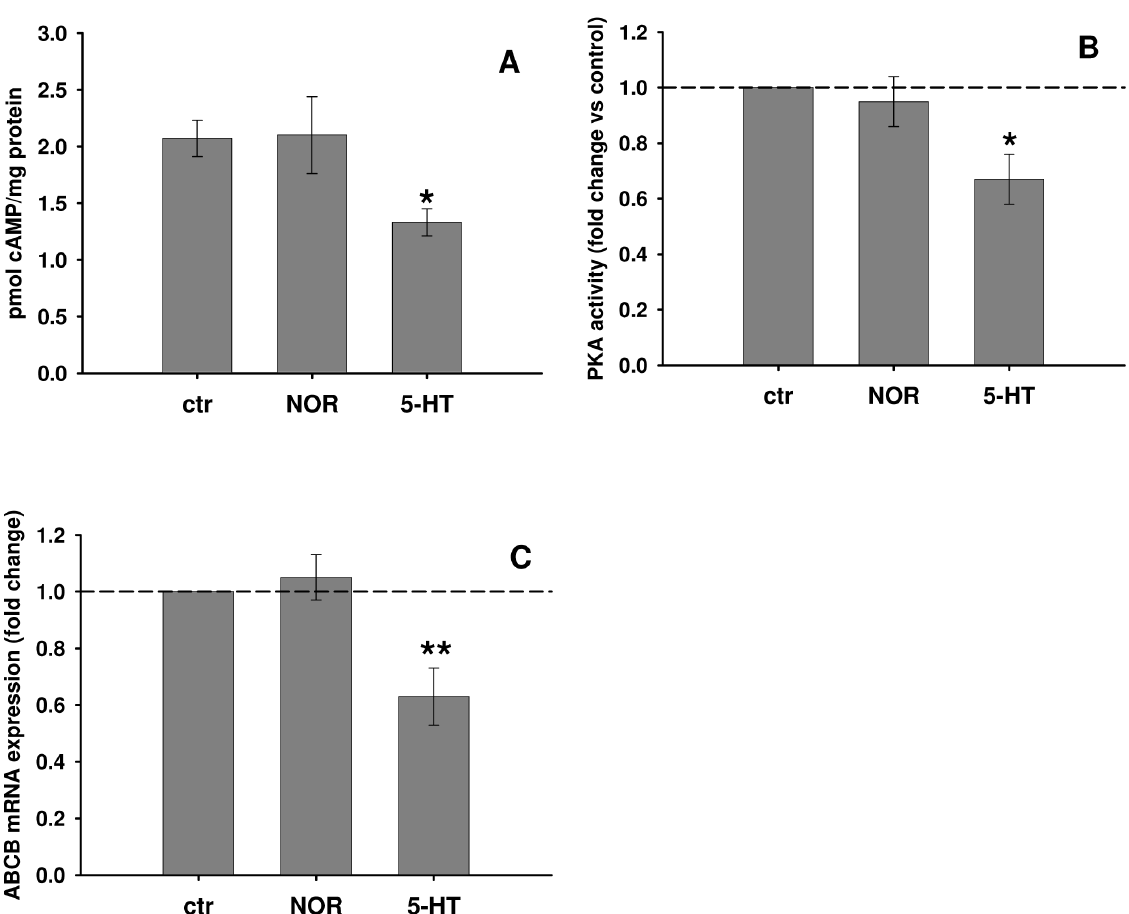
Figure 2. Effects of NOR and 5-HT on cAMP-related parameters and ABCB mRNA expression in mussel haemocytes incubated in vitro . (A) cAMP content; (B) relative PKA activities; (C) relative ABCB mRNA expression. All biological endpoints were assessed after 1 h of exposure to 1 m M NOR or 5-HT. Data are derived from three independent experiments (mean 6 SEM); *p , 0.05 vs control. Basal PKA activity=1.12 6 0.17 nmol/ min/mg protein.